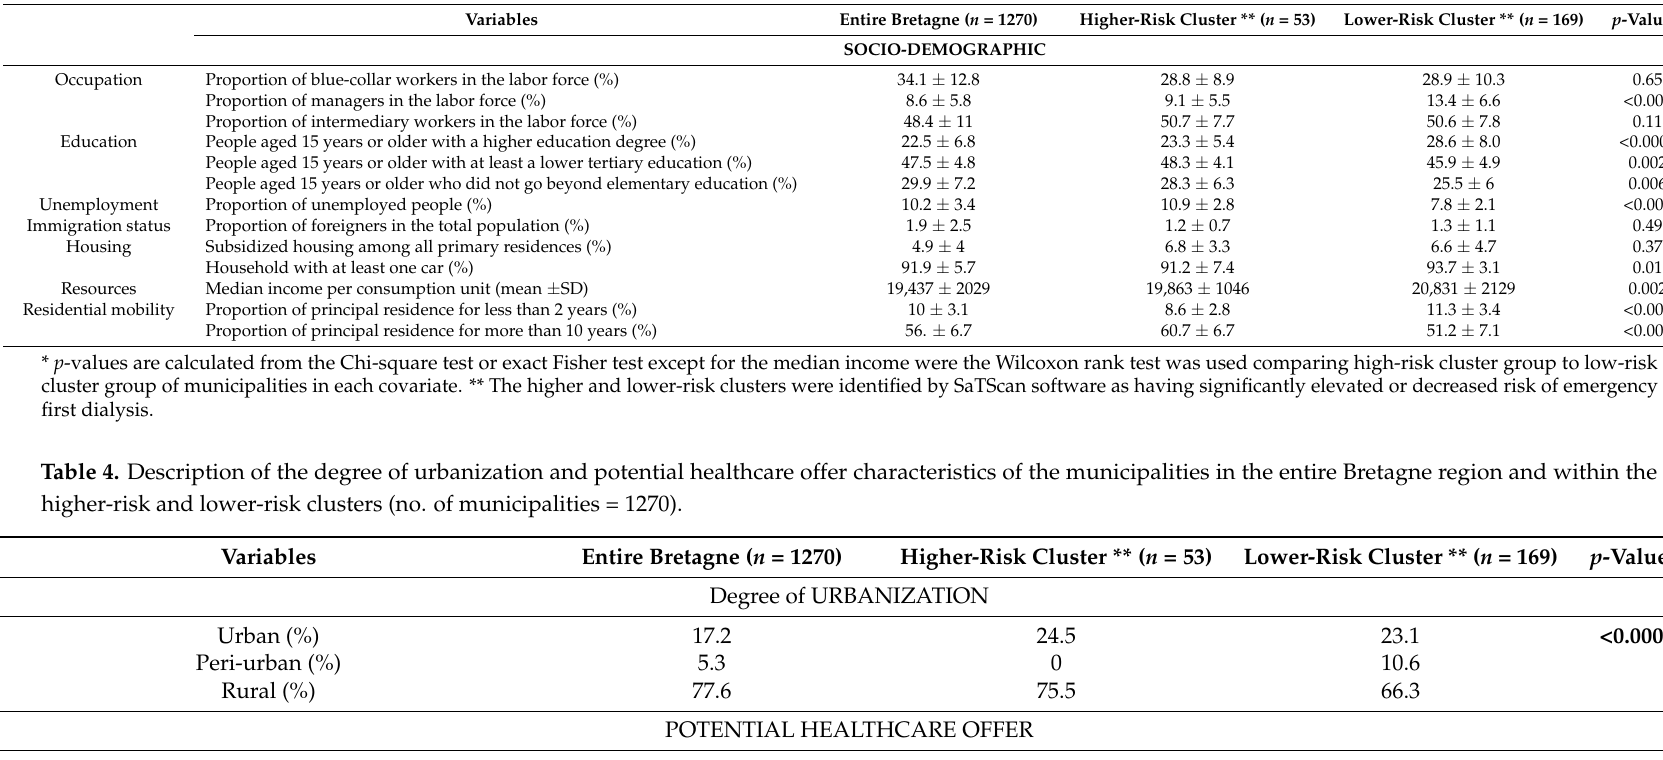
Table 3. Description of the socio-demographic characteristics of the municipalities in the entire Bretagne region and within the higher-risk and lower-risk clusters (no. of municipalities = 1270).